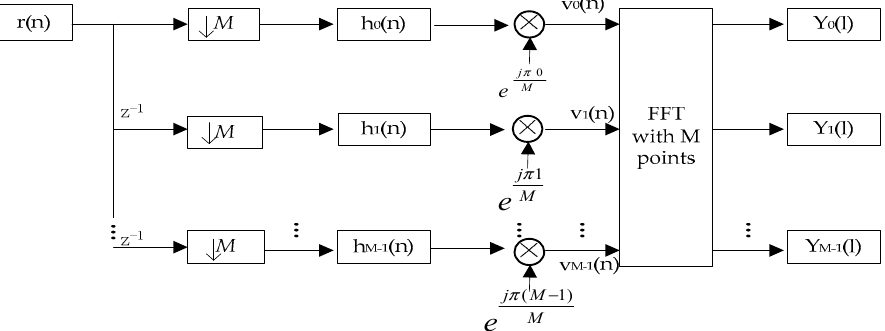
Figure 5. Sub-bands division based on improved P-DFTFB.